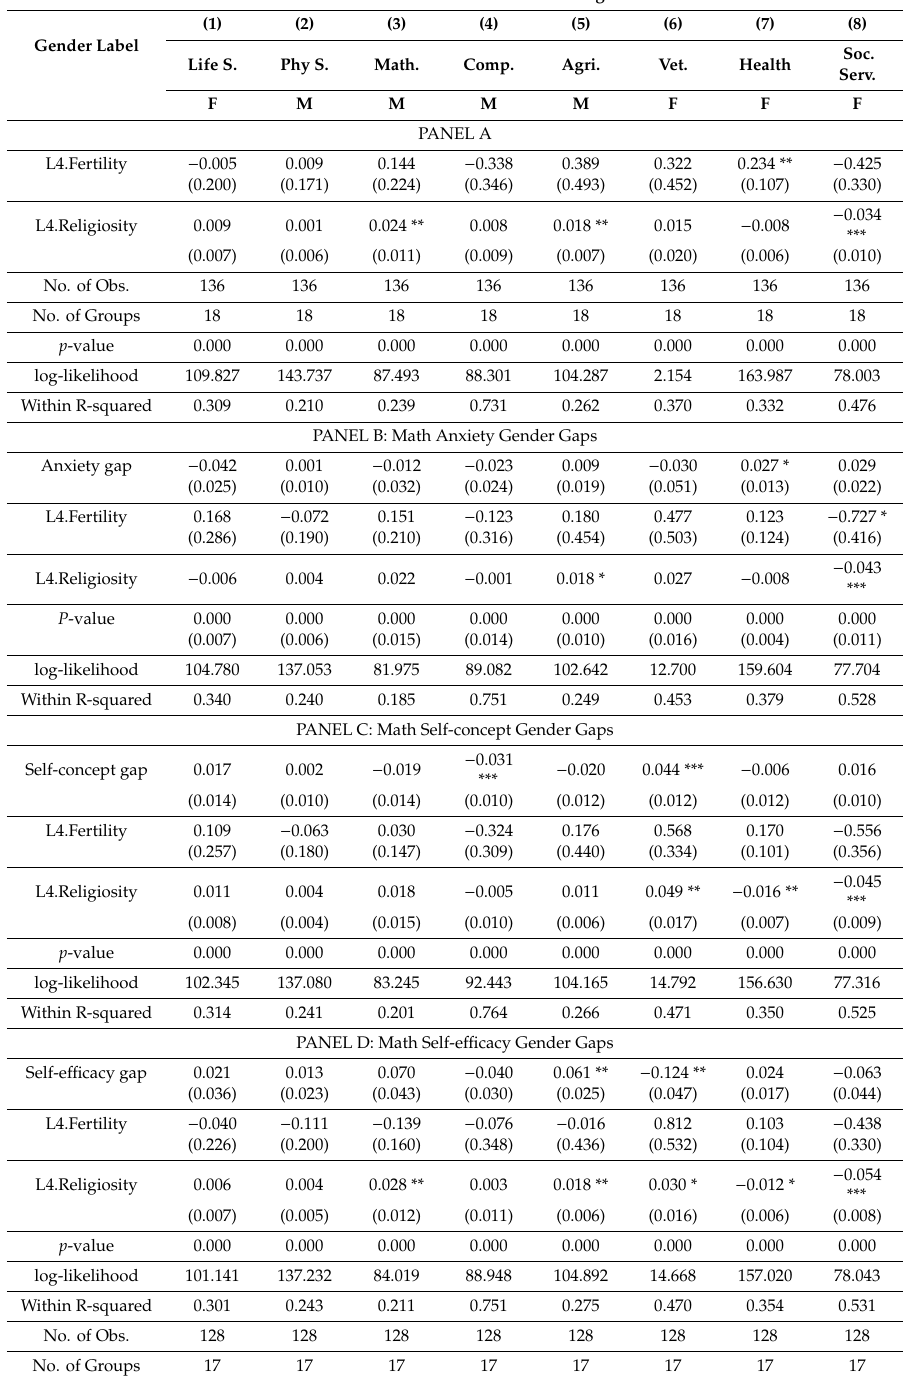
Table 4. Subfield-level Segregation (selected subfields). Dependent variable: Association Index (subfields). Science Agriculture Health & Welfare